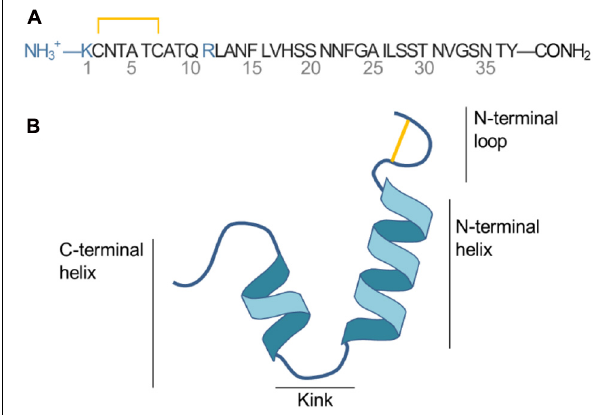
FIGURE 1 | (A) Sequence of IAPP. (B) Sketch of the secondary structure of IAPP in the helical kinked